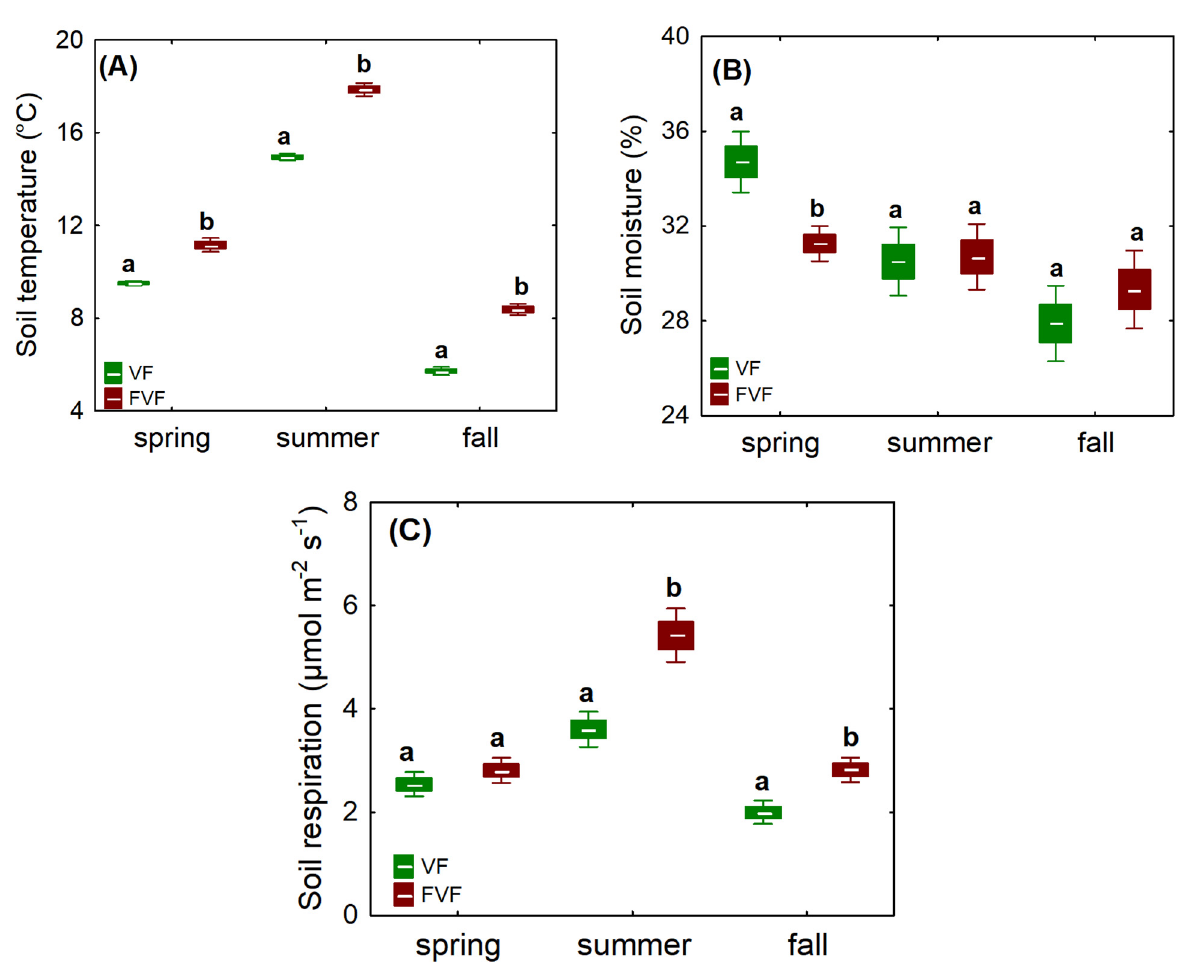
Figure 5. Boxplots of ( A ) soil temperature, ( B ) soil moisture, ( C ) and soil respiration along seasons per forest type (i.e., VF and FVF). Different letters (i.e., ( a ) and ( b )) mean significant differences between the VF and FVF within each season. Boxes bound the standard errors of the mean. Whiskers represent the 95% con fi dence intervals and horizontal lines within boxes represent the mean values.